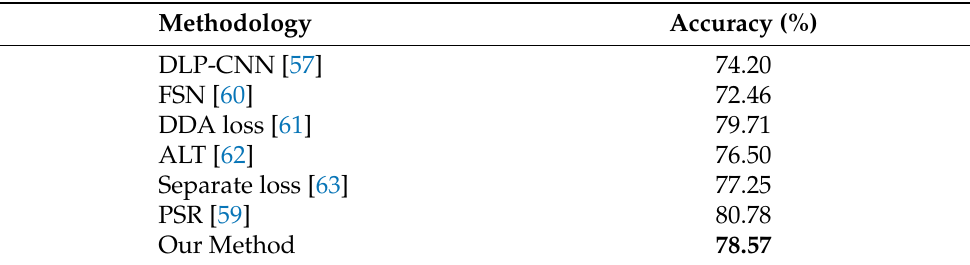
Table 6. Performance comparison on RAF-DB dataset.